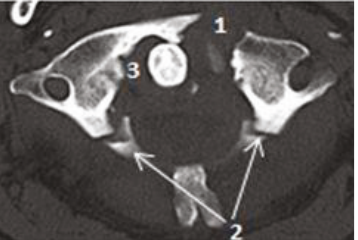
Figure 2: Cervical spine CT scan showing type III Je ff erson fracture with anterior arch fracture (1) and posterior arch fractures (2). Note the widening of the atlantodens interval (3).